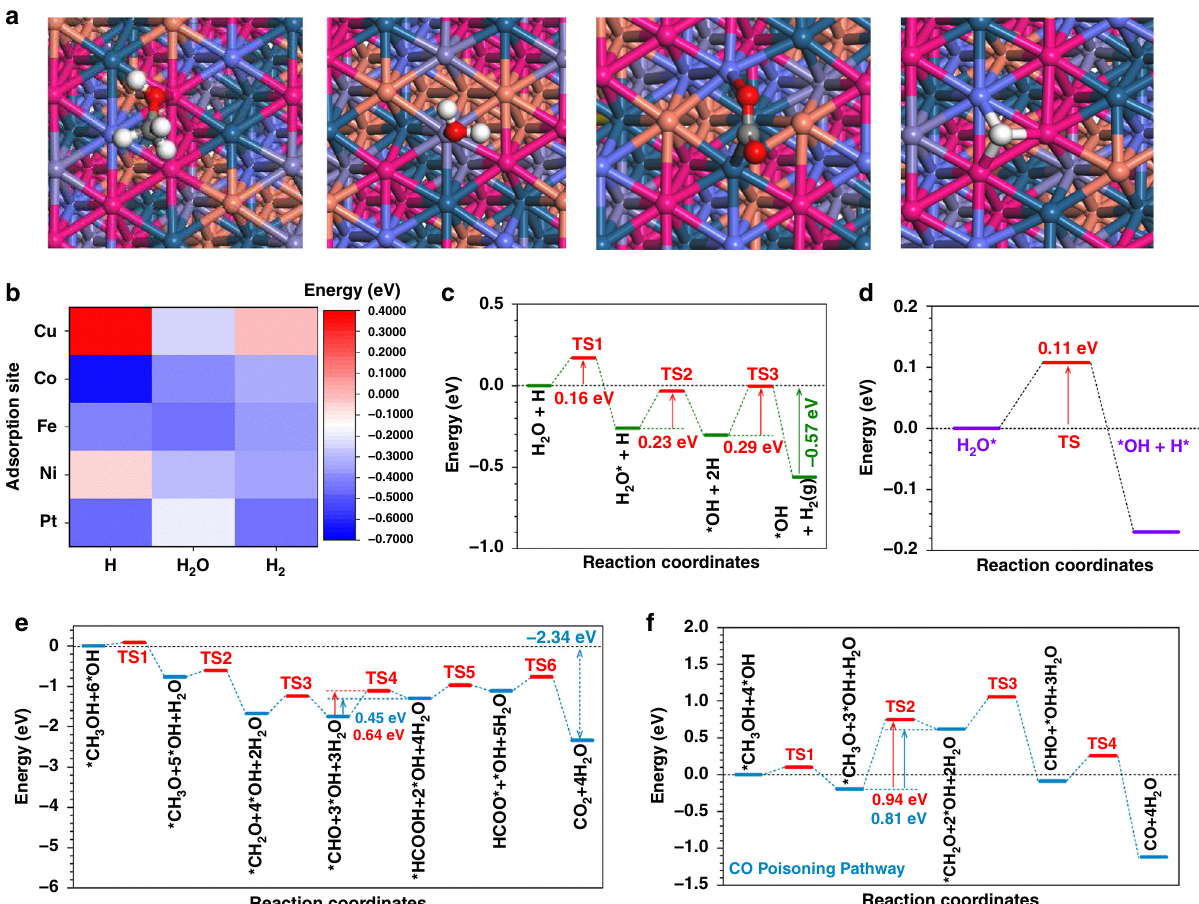
Fig. 5 Density functional theory calculations for the structural con fi guration and energetic reaction pathways. a The structural con fi guration of stable adsorption of key intermediates in HER and MOR. From left to right: CH 3 OH, H 2 O, CO 2 , H. Dark green balls = Pt; Gray balls = Fe; Blue balls = Co; Pink balls = Ni; Orange balls = Cu; Red balls = O and White balls = H. b The binding energy mapping of HER. c The energetic pathway of the alkaline HER. d The activation energies of water dissociation. e The energetic pathway of the alkaline MOR. f The energetic pathway of CO